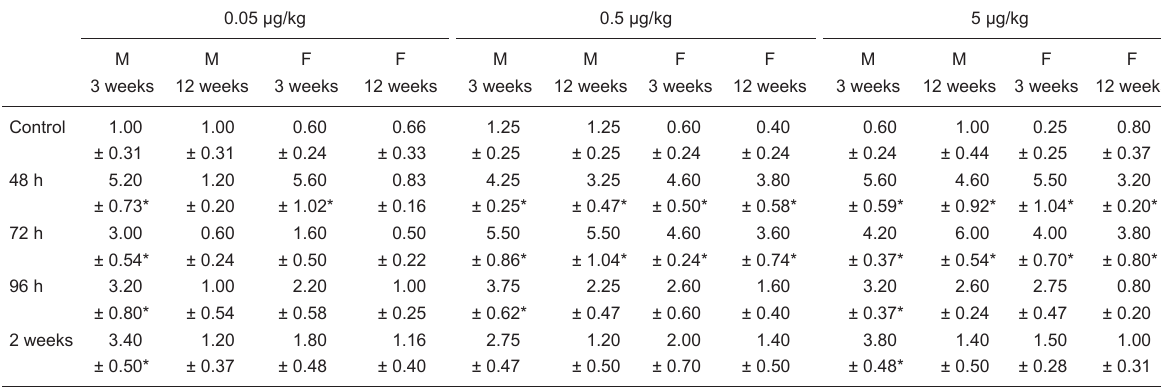
Table 1. Descriptive statistics regarding micronucleus frequency in 3- and 12-week-old mice exposed to 0.05, 0.5, and 5 µg/kg dieth - ylstilbestrol 48, 72 and 96 h and 2 weeks after